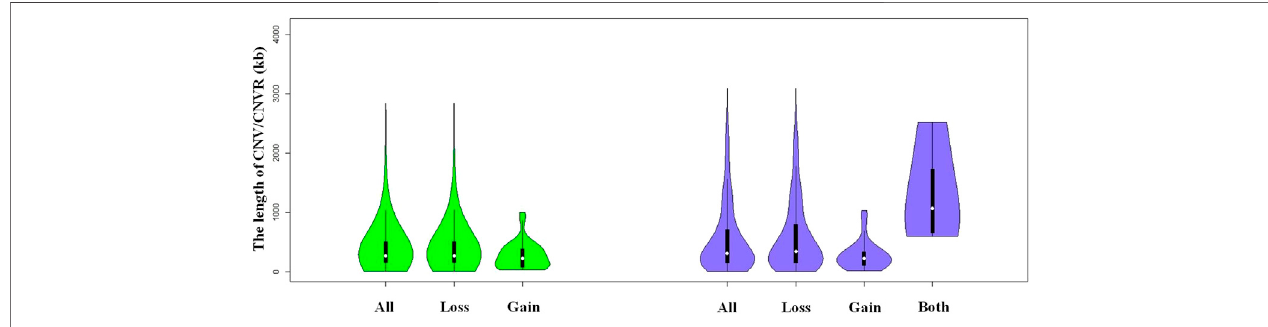
FIGURE 1 | Violin plots of the total CNVs (CNVRs) lengths, gain or loss CNVs (CNVRs) lengths, and both CNVRs lengths in Duroc purebred